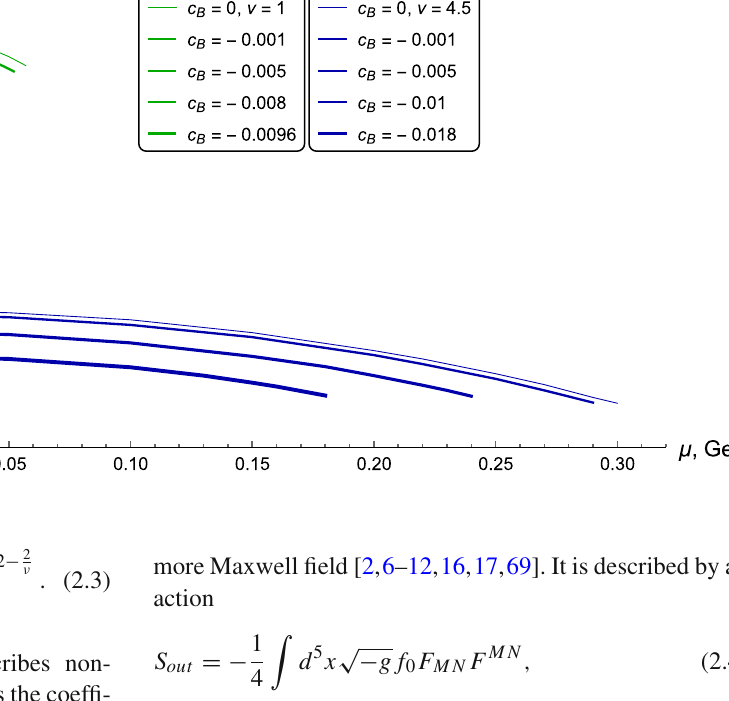
Fig. 1 The BB phase transitions structure from [29] for different anisotropy parameter ν and magnetic field’s parameter c